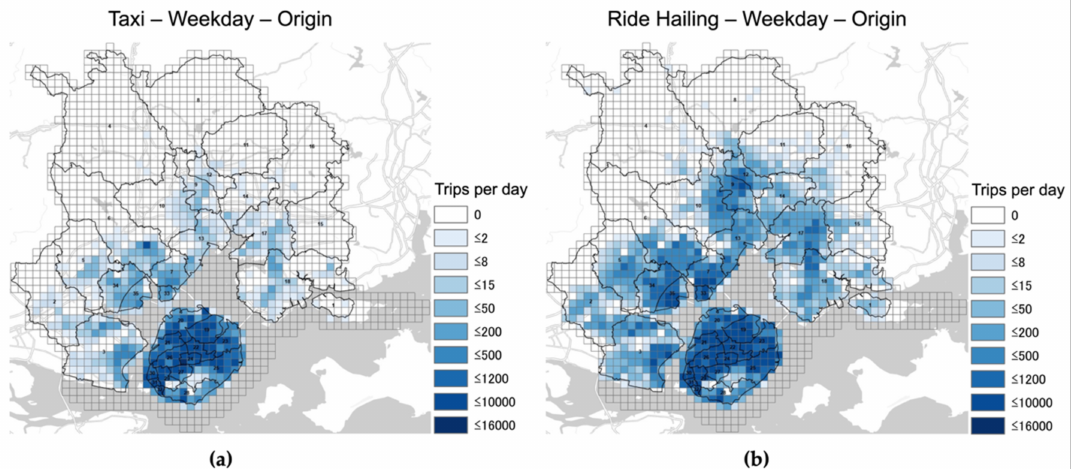
Figure 7. Spatial distribution of average daily outgoing trips of taxis ( a ) and ride-hailing services ( b ) on weekdays.